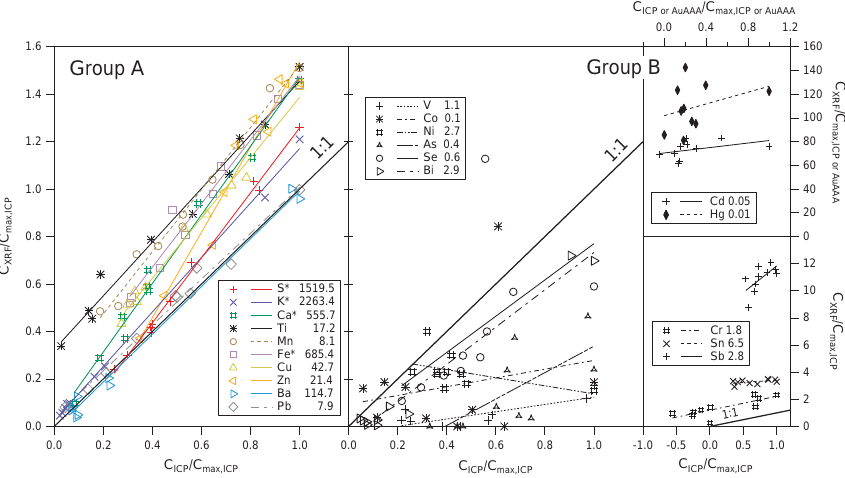
Figure 2. Scatter plots and regression lines of Xact 625 (ordinate) vs. ICP-OES/MS (abscissa) data for groups A and B. Elements with an asterisk ( ∗ ) were analysed with ICP-OES. The axes have been scaled by the maximum concentration C max , ICP indicated in the legends for each element ( C max , AuAAA for Hg). The Levenberg–Marquardt linear least-squares fitting method was applied, taking the ICP measurements as the independent data. Regression equation is y = a + bx . See Table 1 for data.